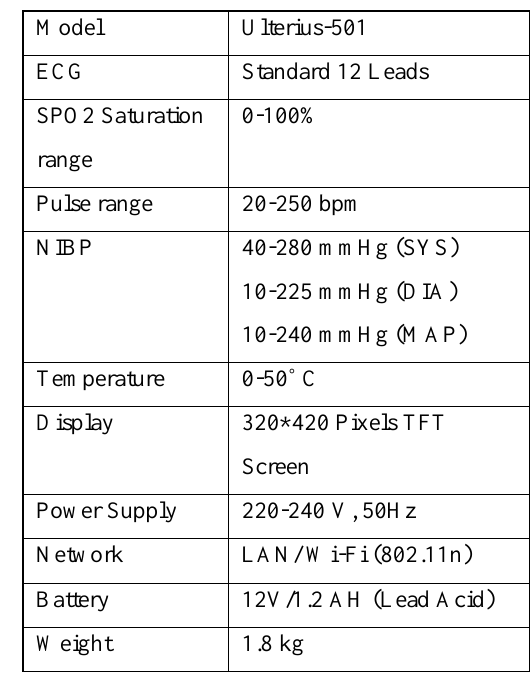
Figure 1 . Five Parameter Vital Sign Monitor